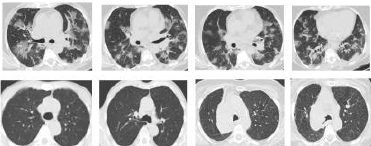
Fig.1 Covid-19 infected (1 st row) and Non-Covid- 19(not normal) (2 nd row) chest CT scans dataset